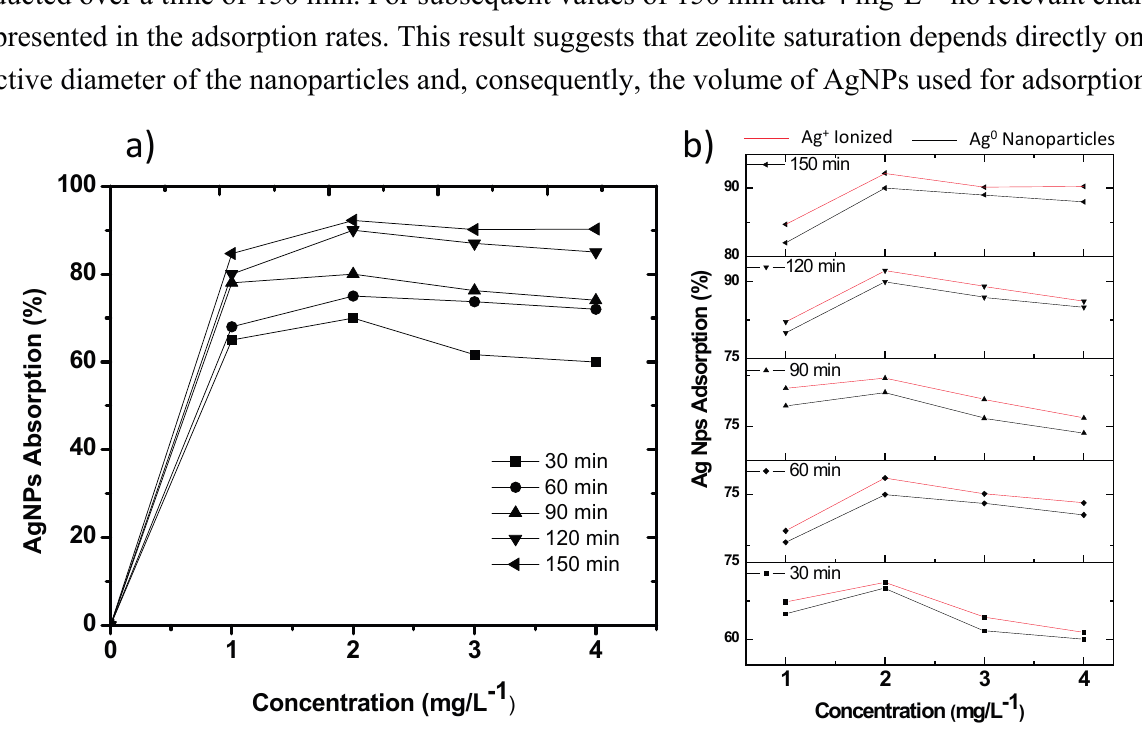
Figure 4. Graphs of the experimental data corresponding to the adsorption efficiency of ( a ) AgNPs and ( b ) AgNPs and Ag ions onto the